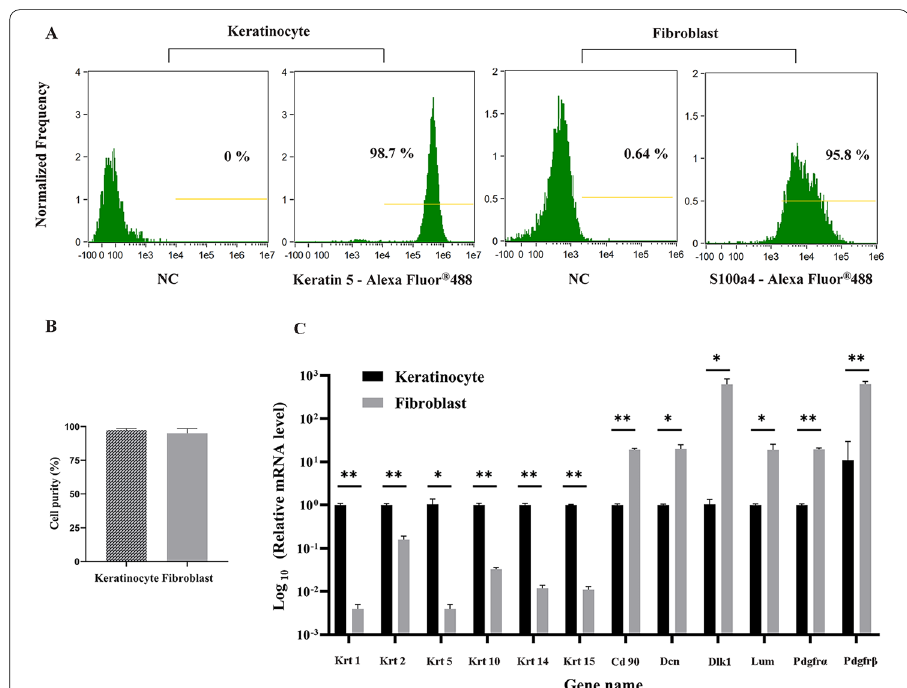
Fig. 1 Identification of keratinocytes and fibroblasts. A The purity of primary keratinocytes and fibroblasts was identified by flow cytometry. B The relative gene expression levels of known marker genes of keratinocytes and fibroblasts were detected by qRT-PCR. The relative mRNA expression was expressed as 2 − ΔΔCT , the Gapdh gene served as an internal reference to normalize the target gene expressions. Data are presented as the mean SD from at least three independent experiments. *P < 0.05, **P < ±